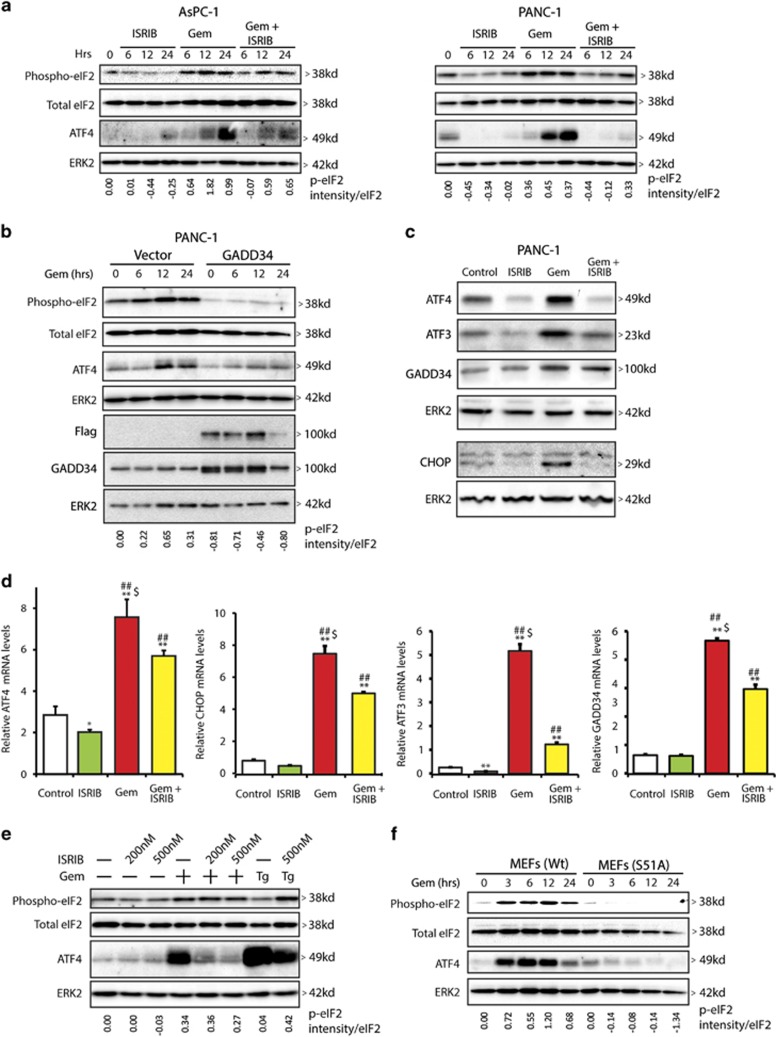
Gemcitabine induces the integrated stress pathway in pancreatic cancer cells. (a) AsPC-1 and PANC-1 cells were incubated with 0.5 μM ISRIB or 10 μM Gem for indicated times and protein lysates were analyzed by immunoblotting for phospho-eIF2, total eIF2, and ATF4 using specific antibodies. ERK2 served as loading control. (b) Empty vector or GADD34 expression plasmid DNA was transfected into PANC-1 cells, which were incubated 24 h later with 10 μM Gem. Protein lysates were analyzed by immunoblotting. (c) PANC-1 cells were incubated for 36 h with 0.5 μM ISRIB or 10 μM Gem and protein lysates were analyzed by immunoblotting for ATF4, ATF3, GADD34, and CHOP using specific antibodies. ERK2 served as loading control. (d) PANC-1 cells were incubated with 0.5 μM ISRIB or 10 μM Gem for 24 h. ATF4, CHOP, ATF3, and GADD34 mRNA levels were measured using qRT-PCR. Relative actin mRNA levels were used for normalization. Data are the means±S.D. from three experiments. *P<0.05, **P<0.001 compared with control, ##P<0.01 compared with ISRIB, and $P<0.05 compared with Gem+ISRIB. (e) MEFs were incubated for 6 h with 10 μM Gem in the absence and presence of ISRIB. As a positive control, MEFs were also incubated for 6 h with thapsigargin (0.1 μM). (f) Wild-type MEFs or MEFs mutated for eIF2α at serine 51 (to alanine) were incubated with 10 μM Gem for indicated time point and analyzed by immnuoblotting. Panels (a, b, d and e) show representative data from three independent experiments